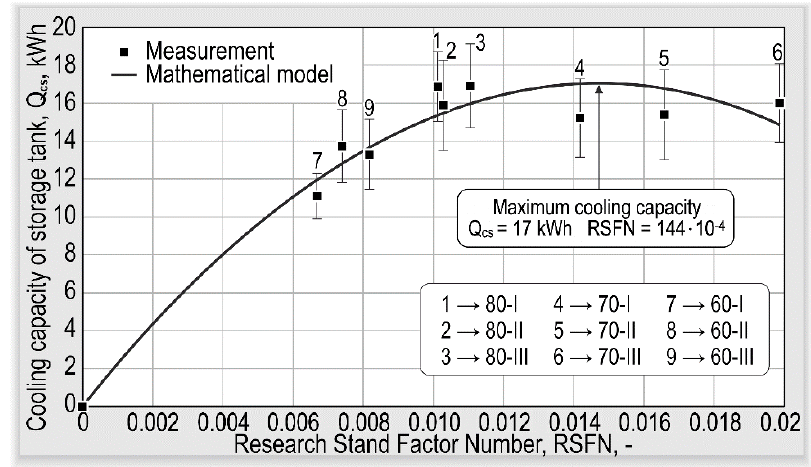
Figure 8. Distribution of measurement results and the values of the mathematical model of cooling capacity as a function of the operation conditions of the prototype cold accumulator.